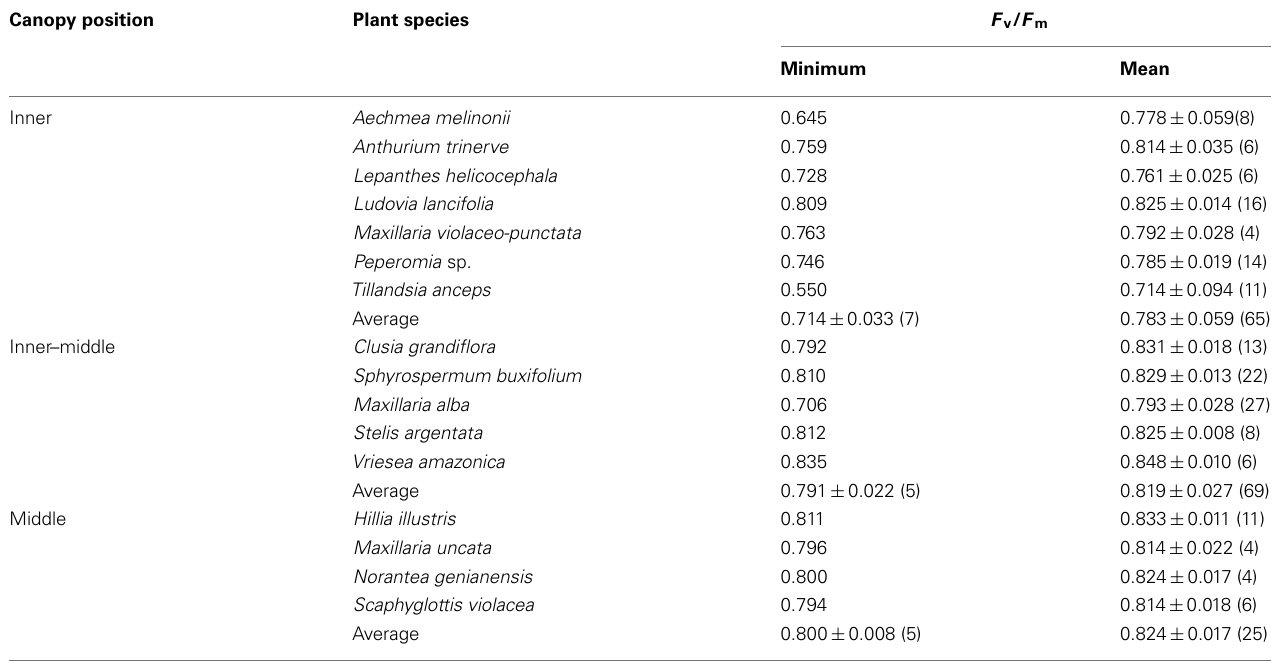
Table 2 | Predawn values of potential quantum yield of the epiphytes grouped according to their position within the canopy of the host tree Virola michelii